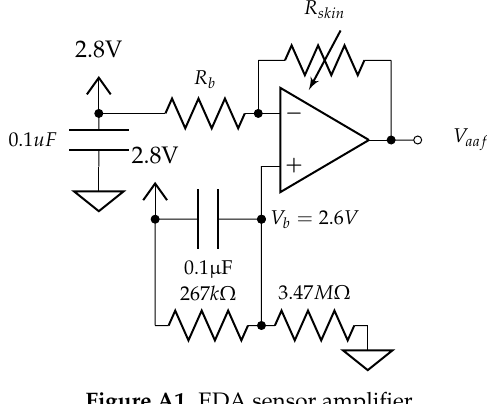
Figure A1. EDA sensor